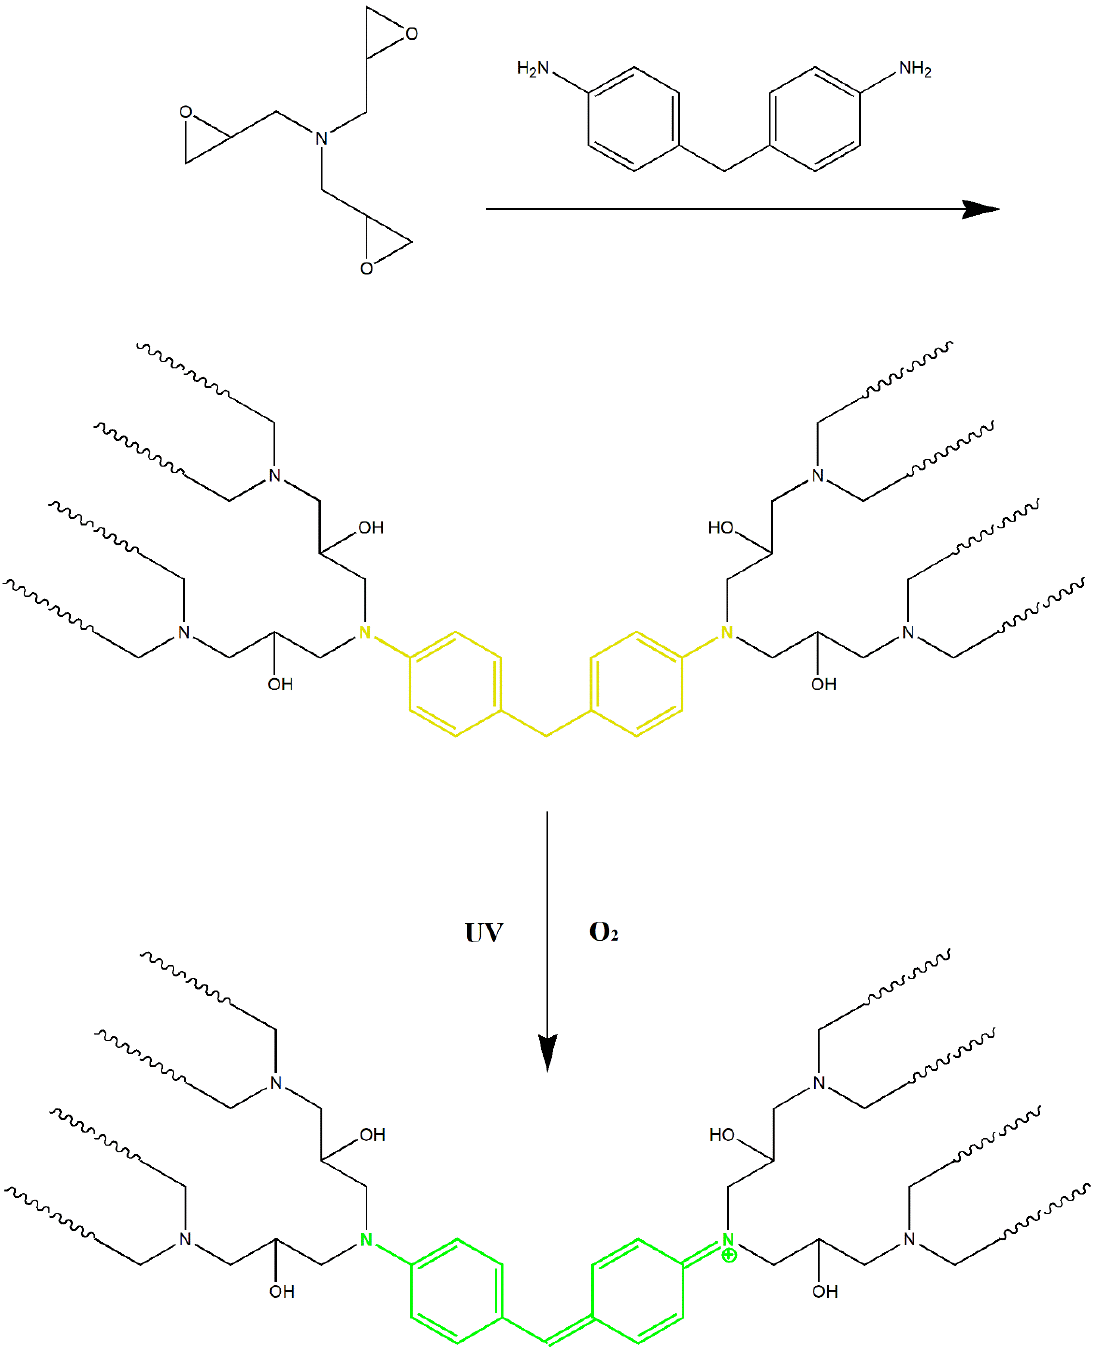
Figure 7. The change in the structure of tris(oxiran-2-ylmethyl)amine/DDM epoxy resin during the photochromic process.